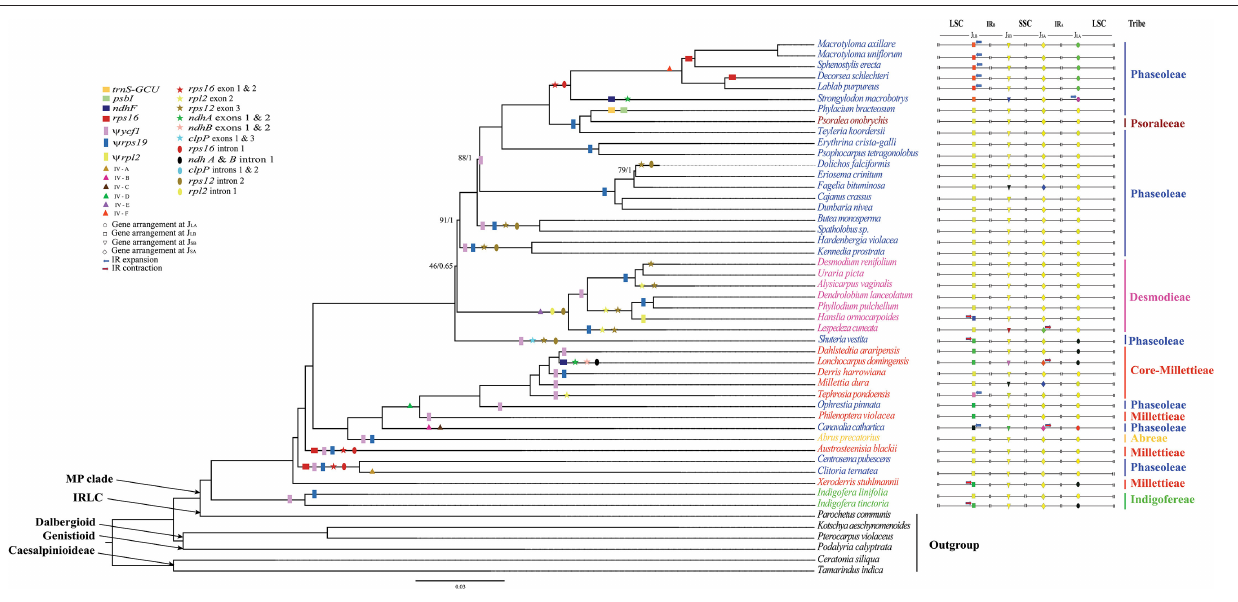
FIGURE 1 | The ML tree of the MP clade reconstructed based on the CP and the variation of IR/SC junctions. Numbers at nodes correspond to ML bootstrap percentages (only values < 100% are shown) and Bayesian inference (BI) posterior probabilities (only probabilities < 1.0 are shown). Genes loss, pseudogenes, inversions (IV), exon and intron loss, in the plastome, are indicated on the branches using coloured squares, rectangles, triangles, stars and oval shapes, respectively. The IR expansion and contraction are shown by blue and red arrow,